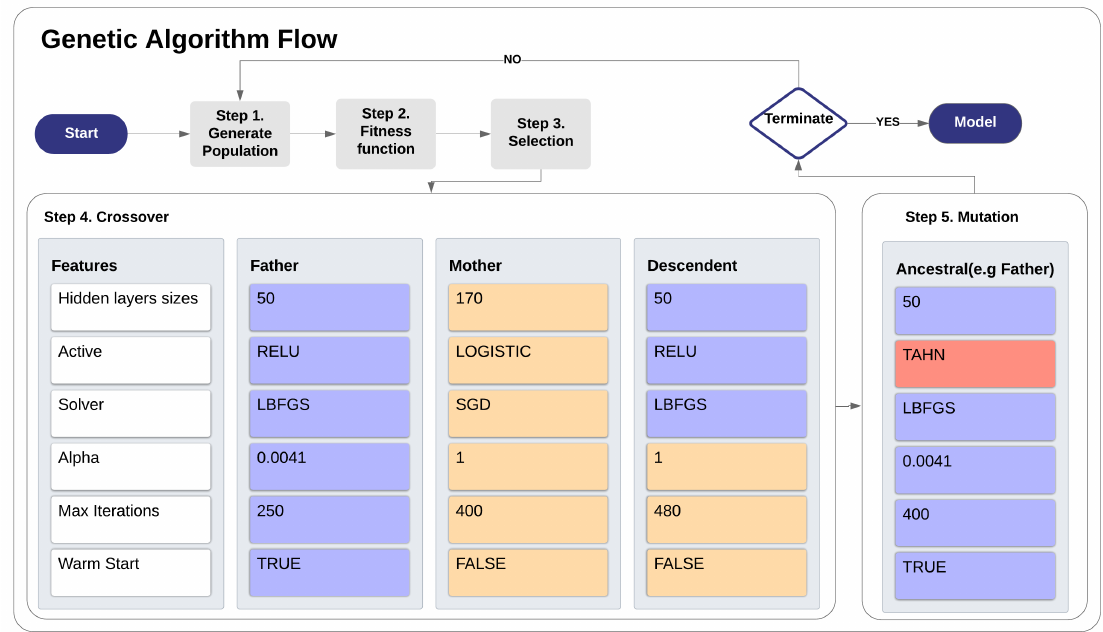
Figure 5. Genetic algorithm flow: An example of crossover and mutation with a multilayer perceptrons (MLP)